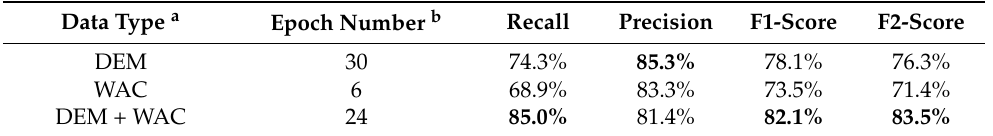
Table 3. Experiments on single data input and dual data input derived from the individual best